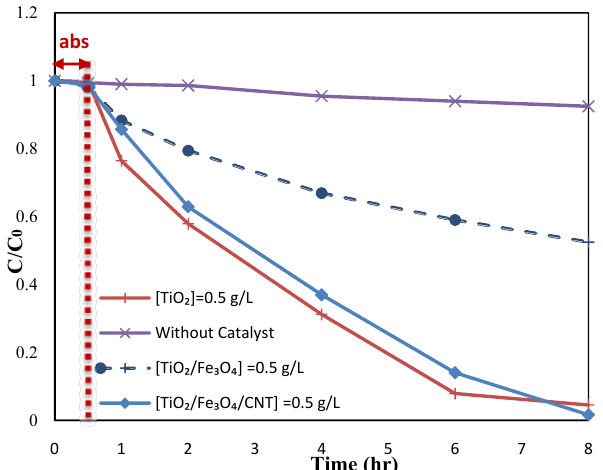
Fig. 12. The rate of removal of acid red 14 by TiO 2 , TiO 2 /Fe 3 O 4 and TiO 2 /Fe 3 O 4 / MWCNT